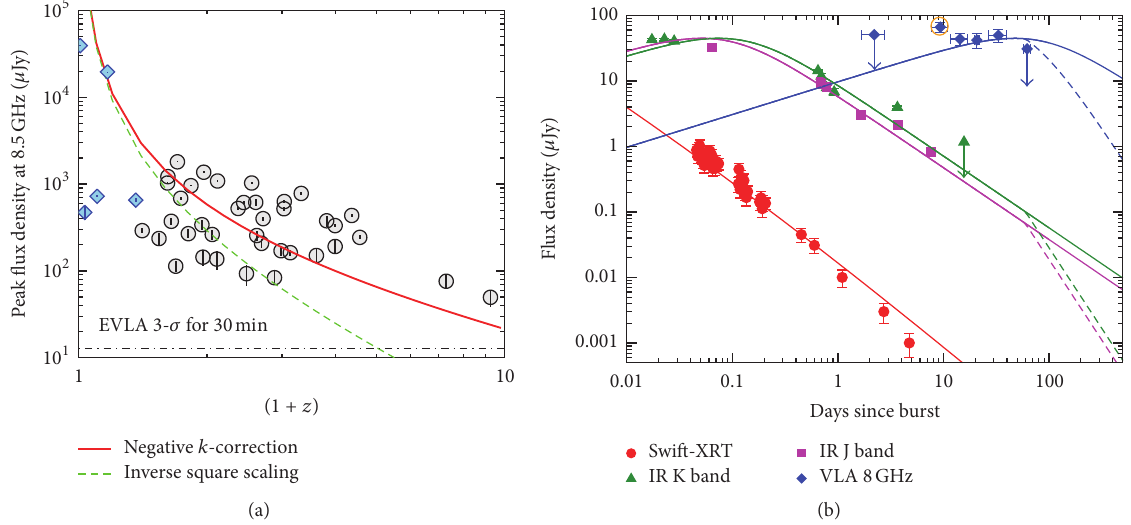
Figure 5: (a) The 8.5 GHz radio peak flux density versus ( 1 + 𝑧 ) plot for radio afterglows with known redshifts. Blue diamonds are GRBs associated with supernovae, while the grey circles denote cosmological GRBs. The green dashed line indicates if the flux density scales as the inverse square of the luminosity distance. The red thick line is the flux density scaling in the canonical afterglow model which includes a negative 𝑘 -correction effect, offsetting the diminution in distance (reproduced from [48]). (b) Multiwaveband afterglow modeling of highest redshift GRB 090423 at 𝑧 = 8.23 (reproduced from